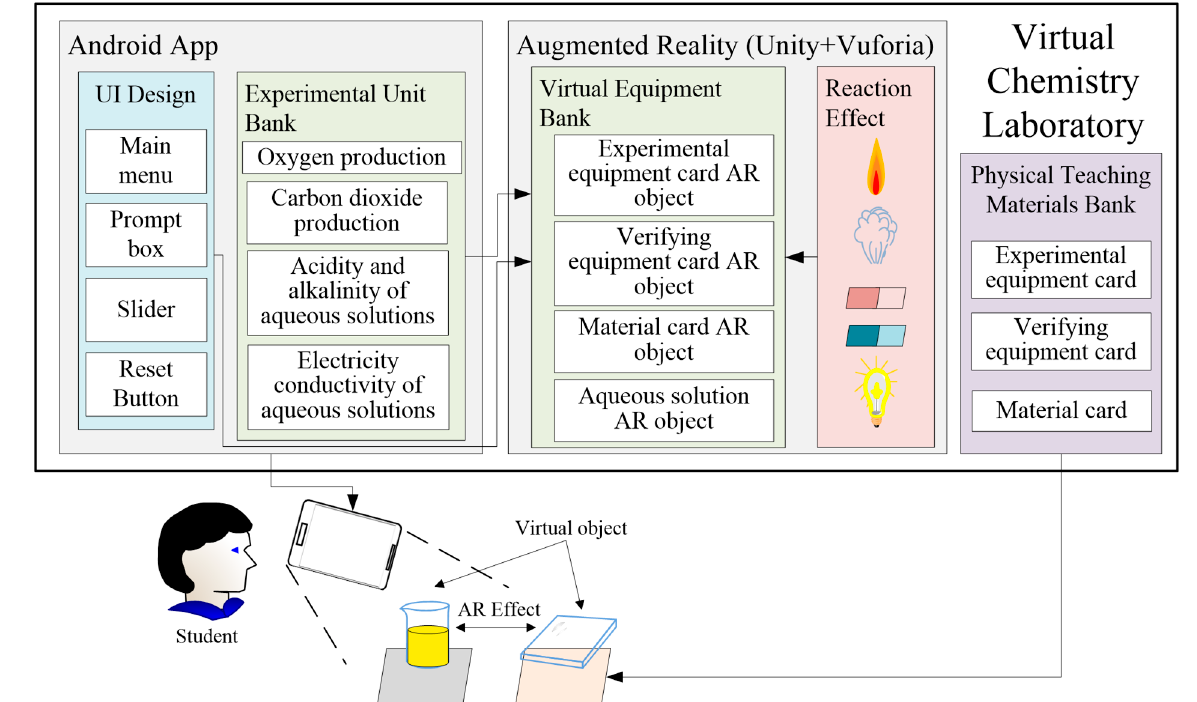
Figure 5. Architecture of the proposed virtual chemistry